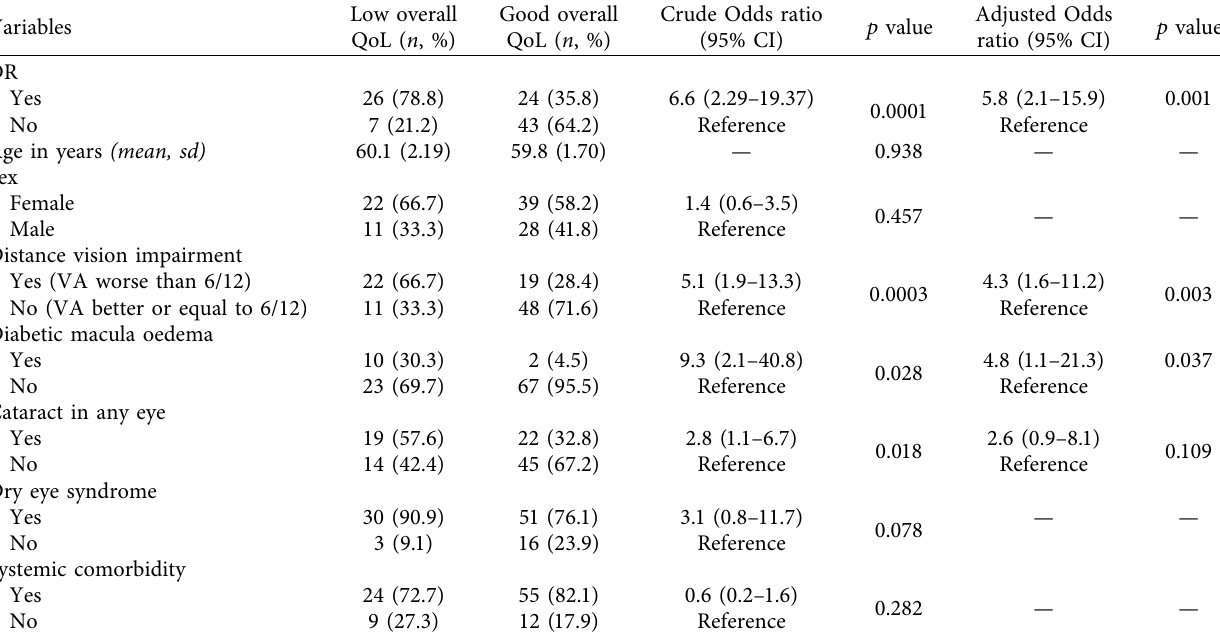
Table 4: Binominal logistic regression of general vision for all DM patients ( N �